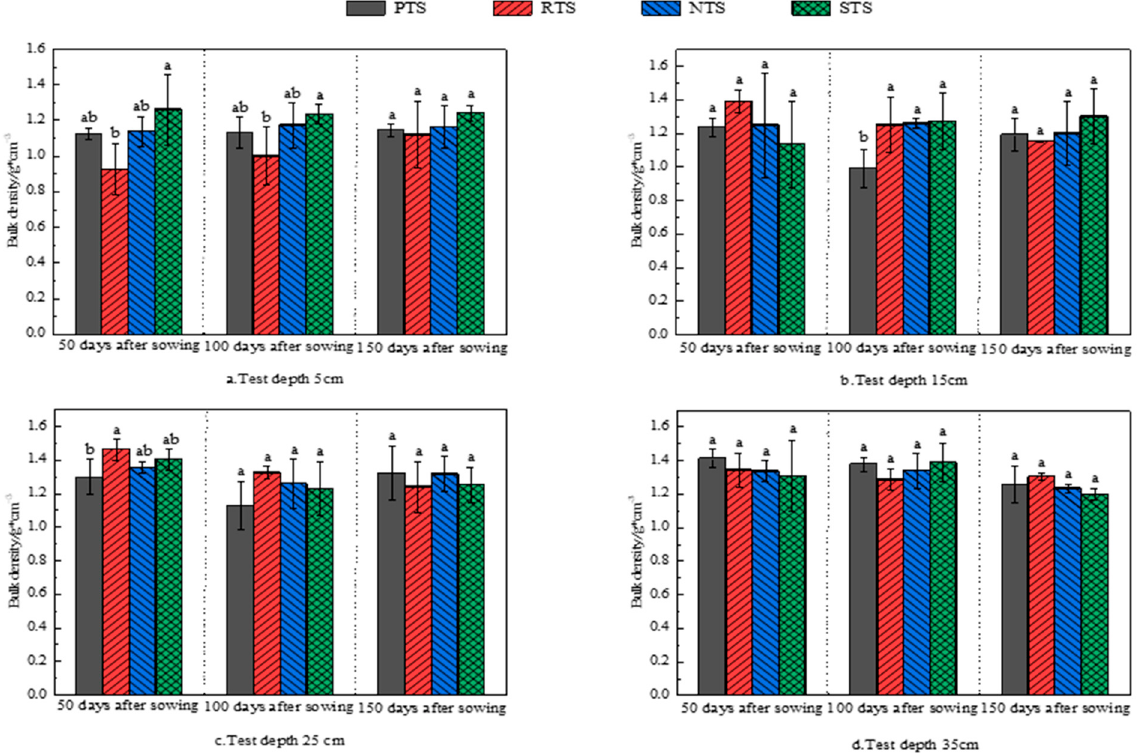
Figure 4. Effect of tillage and sowing methods on soil bulk density. Note: PTS—plow tillage and sowing; RTS—rotary tillage and sowing; NTS—no-tillage and sowing; STS—no-tillage and precise sowing in stubble field. Different lowercase letters indicate significant differences between the same test time, the same soil depth, and different tillage methods ( p < 0.05).